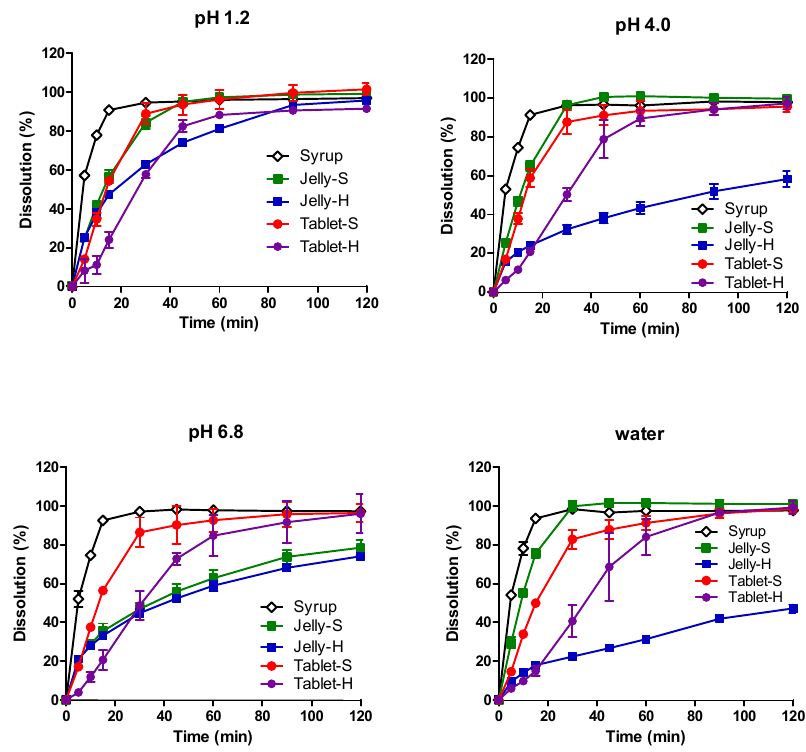
Figure 4. Dissolution profiles of dl-methyl ephedrine hydrochloride from various formulations in pH 1.2, 4.0, 6.8, and water at 37 °C. Each point represents mean ± standard deviation ( n = 6).